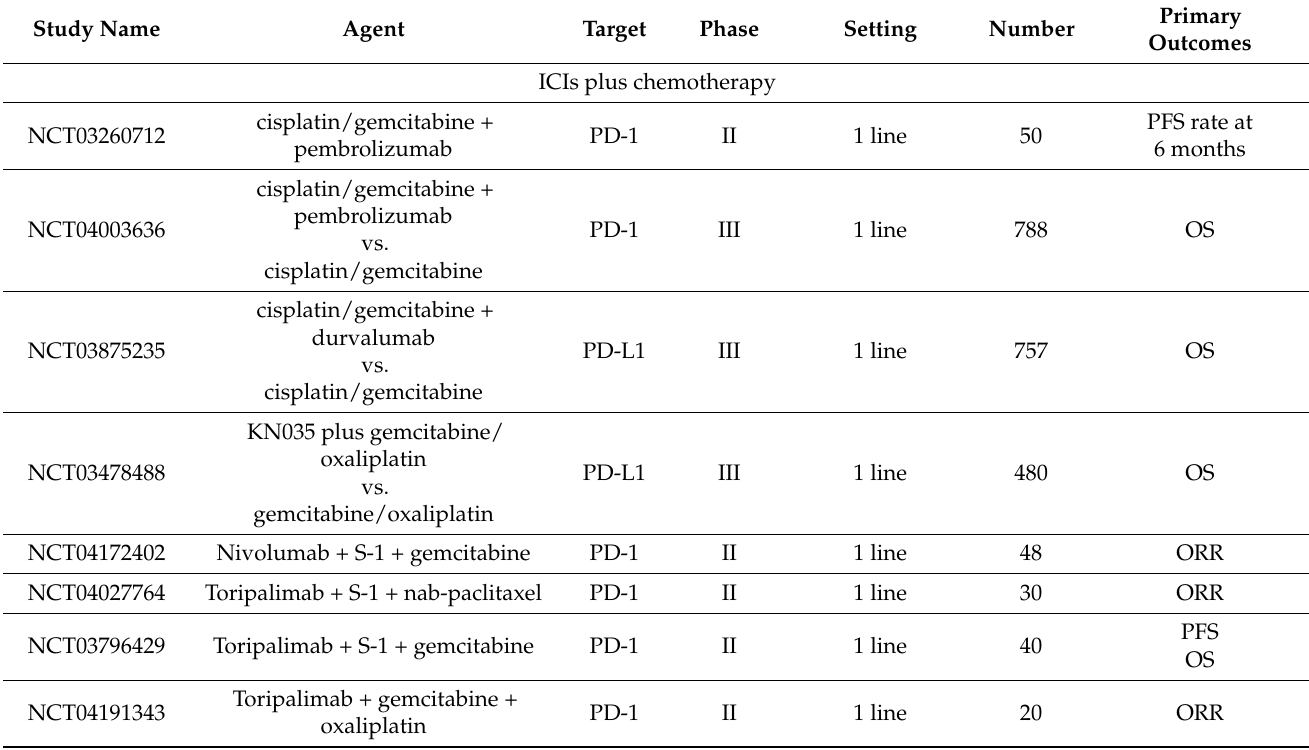
Table 2. On-going clinical